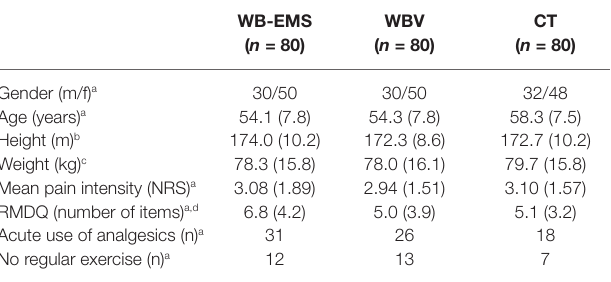
TABLE 1 | Baseline characteristics of the three intervention